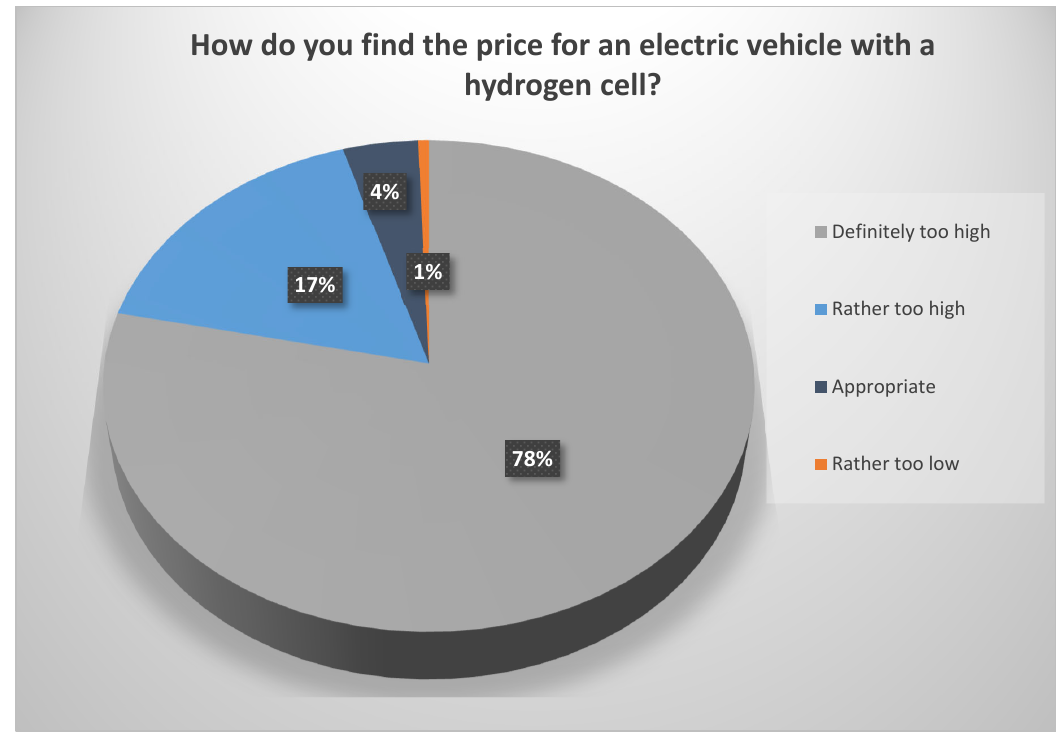
Figure 6. Survey question number 6. Source: own study.